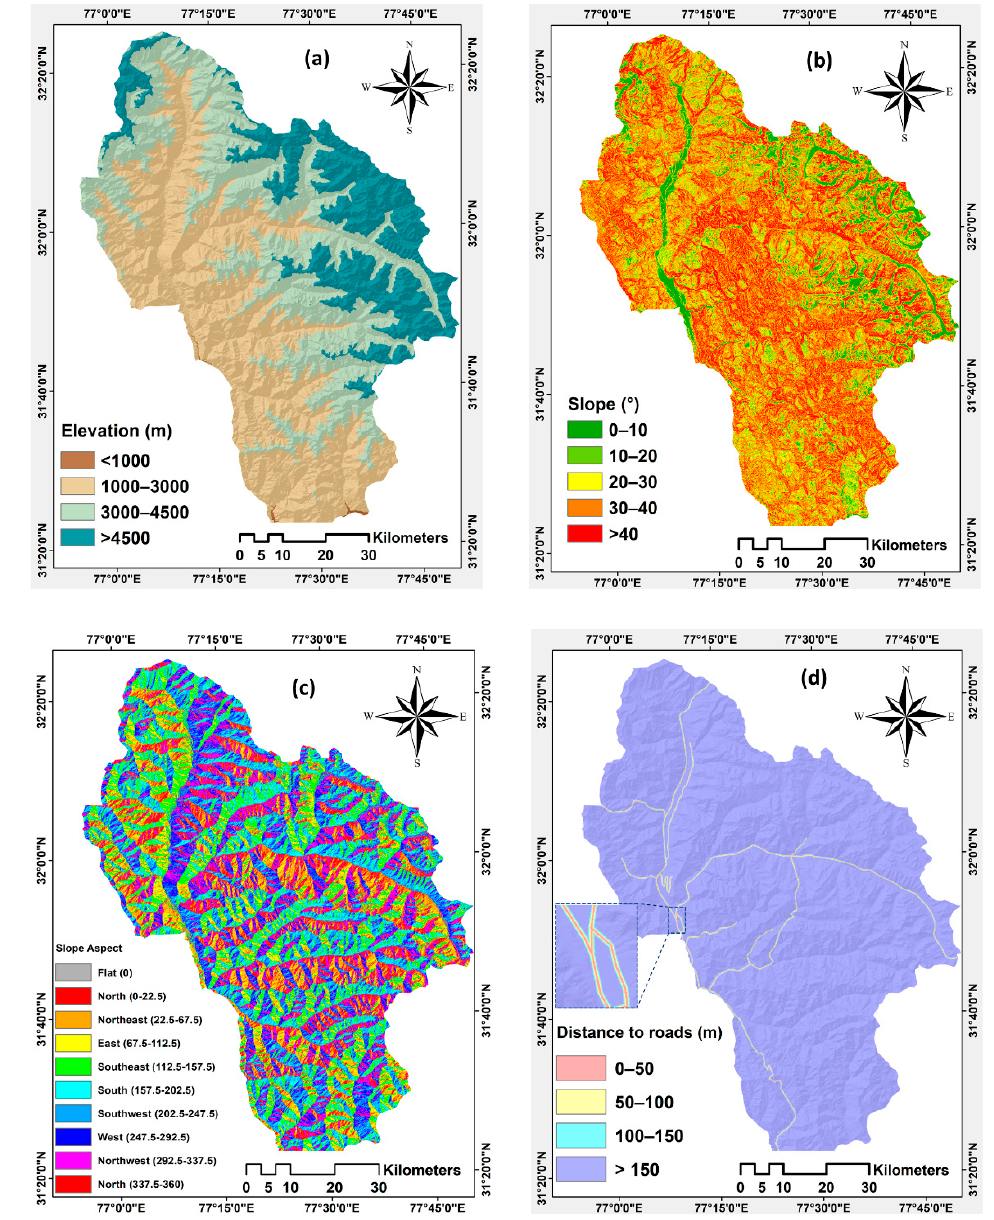
Figure 3. Cont. Figure 3.